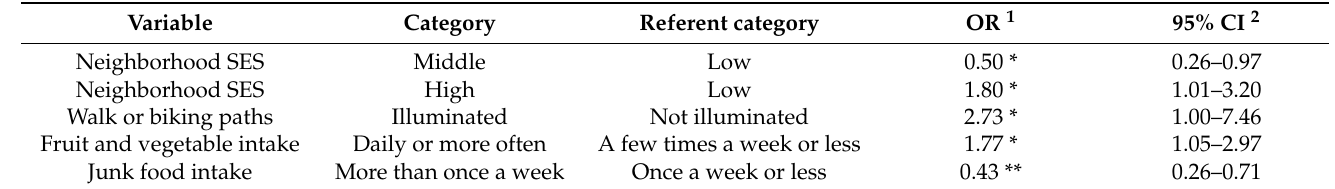
Table 3. Logistic regression results of association of socioeconomic and lifestyle factors associated with active commuting to and from